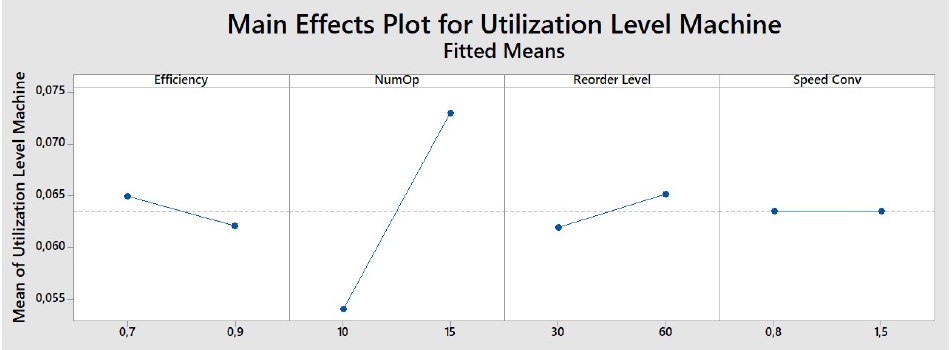
Figure 14. Main Effects Plot for Utilization Level Machine.